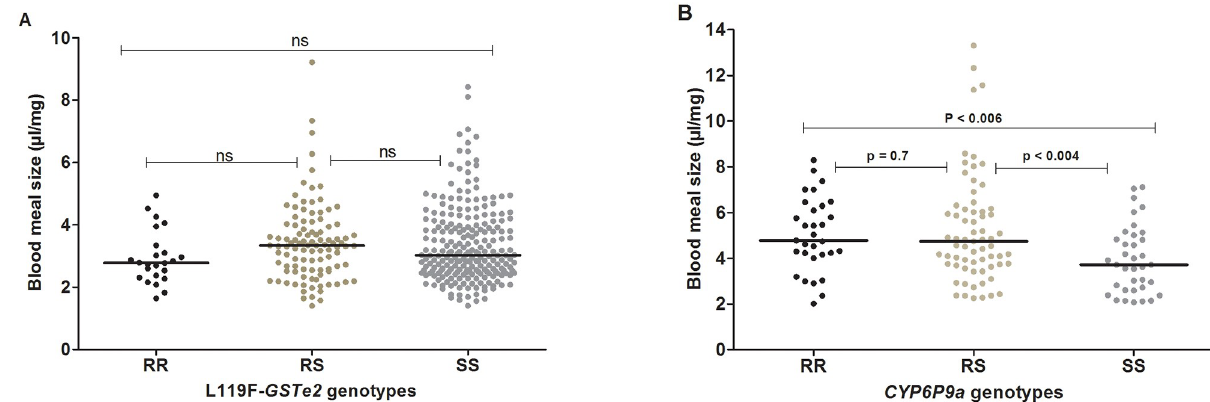
Fig 3. Influence of metabolic resistance on blood meal size of An . funestus mosquitoes. Effect of L119F-GSTe2 (A) and CYP6P9a -R (B).